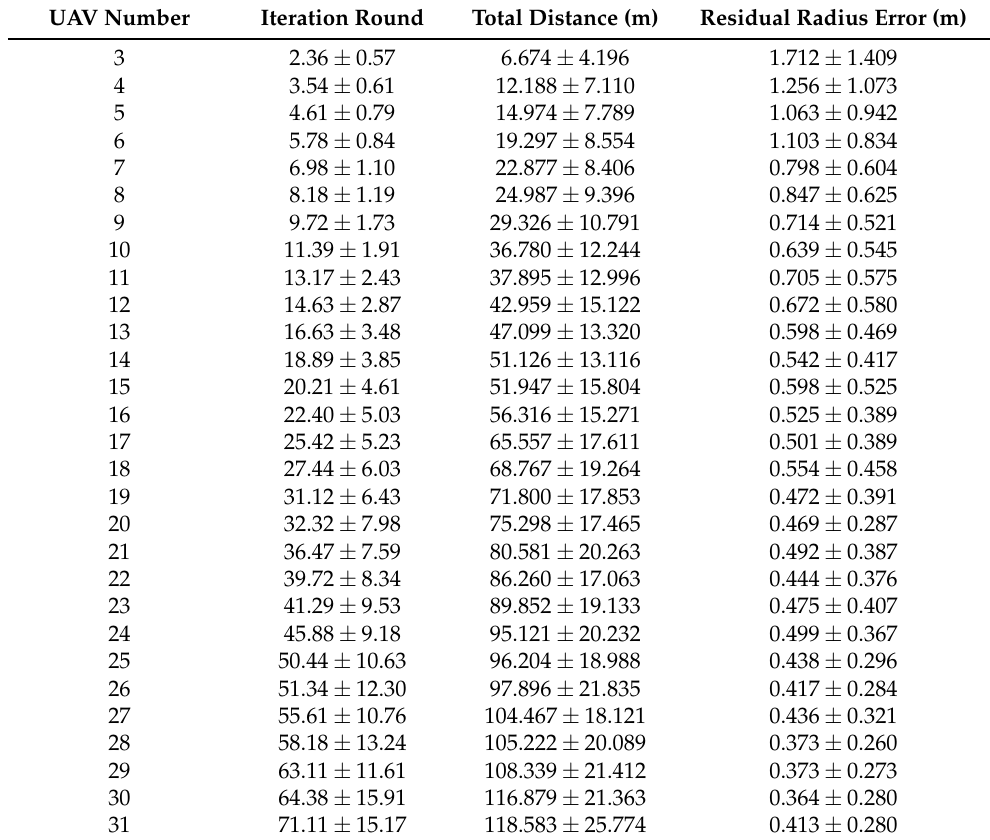
Table 1. Table of the experimental result with E R = 10 − 3 m. UAV Number Iteration Round Total Distance